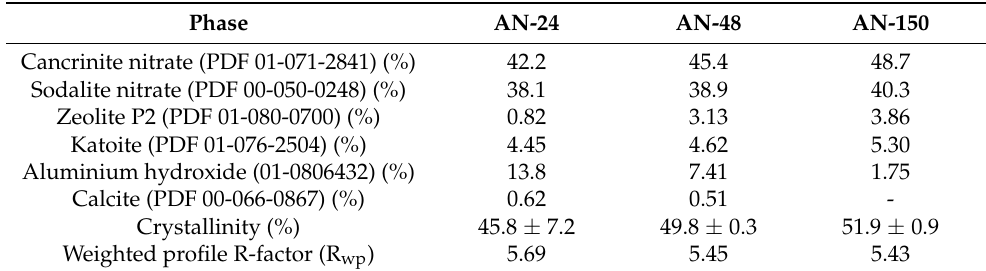
The proportion of each product phase is expressed as a percentage of the total mass of crystalline material within the